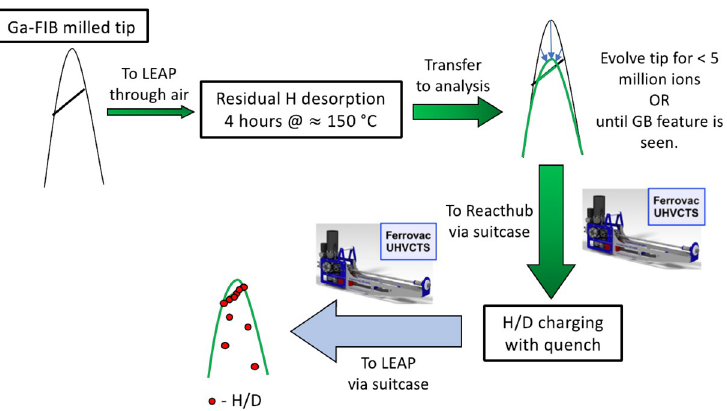
Fig 6. Reacthub protocol for hydrogen charging. Workflow schematic for the deuterium gas charging of grain boundary features in high Mn TWIP steels.